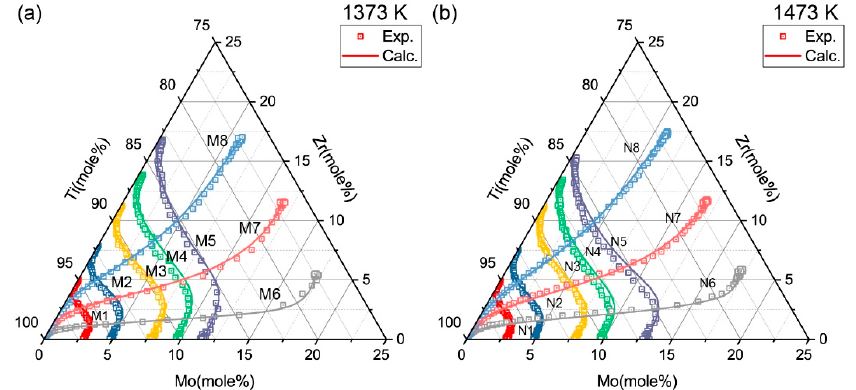
Figure 10. Simulated diffusion paths for diffusion couples compared with the experimental measurements: ( a ) 1373 K and ( b ) 1473 K.